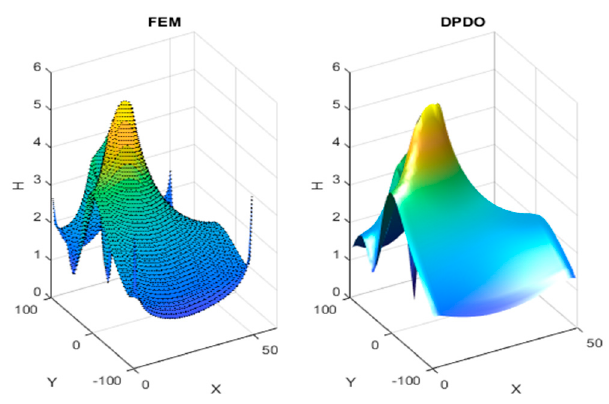
Figure 10. Magnetic field H ( x , y ) in the air window obtained with FEM and DPDO.